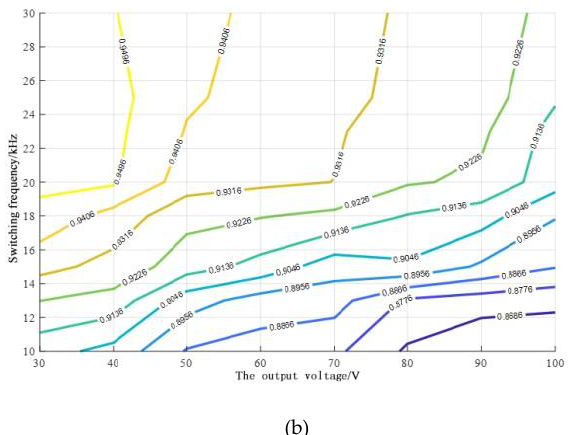
Figure 21. Comparison of efficiency of two converters. ( a ) The efficiency of the proposed converter. ( b ) Efficiency of four-phase interleaved DC/DC converter efficiency.